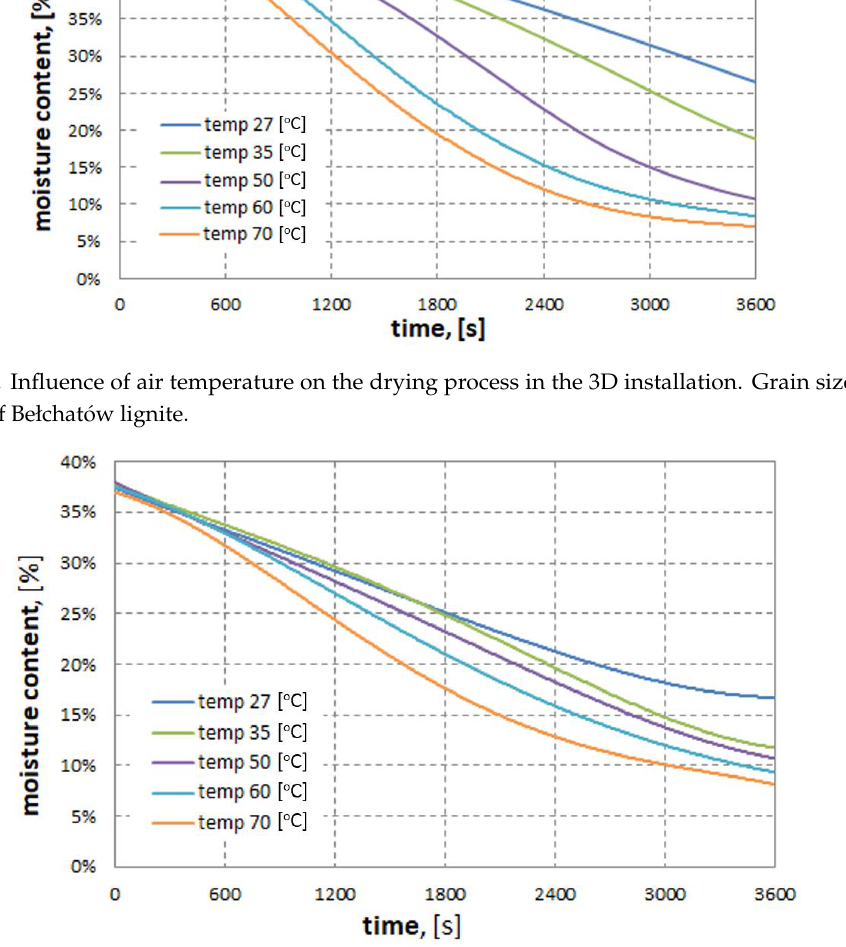
Figure 11. Influence of air temperature on the drying process in the 3D installation. Grain size was 0–8 mm of Bełchatów lignite.